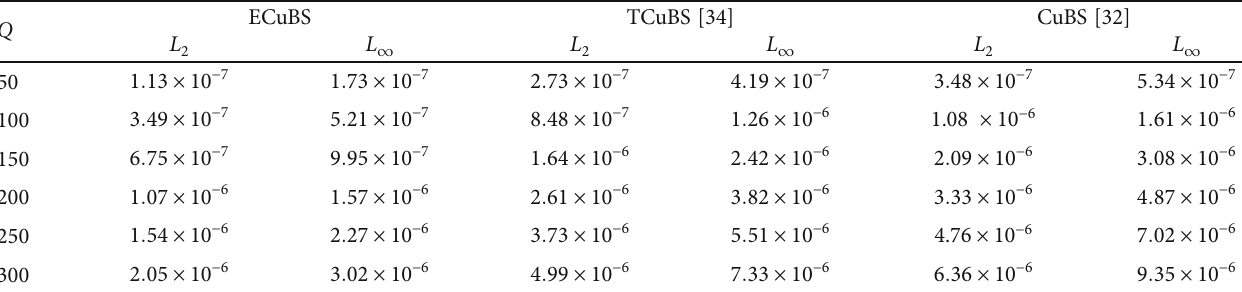
Table 3: Error comparison for Example 7 when N = 50 , and Δ t = 10 − 4 .